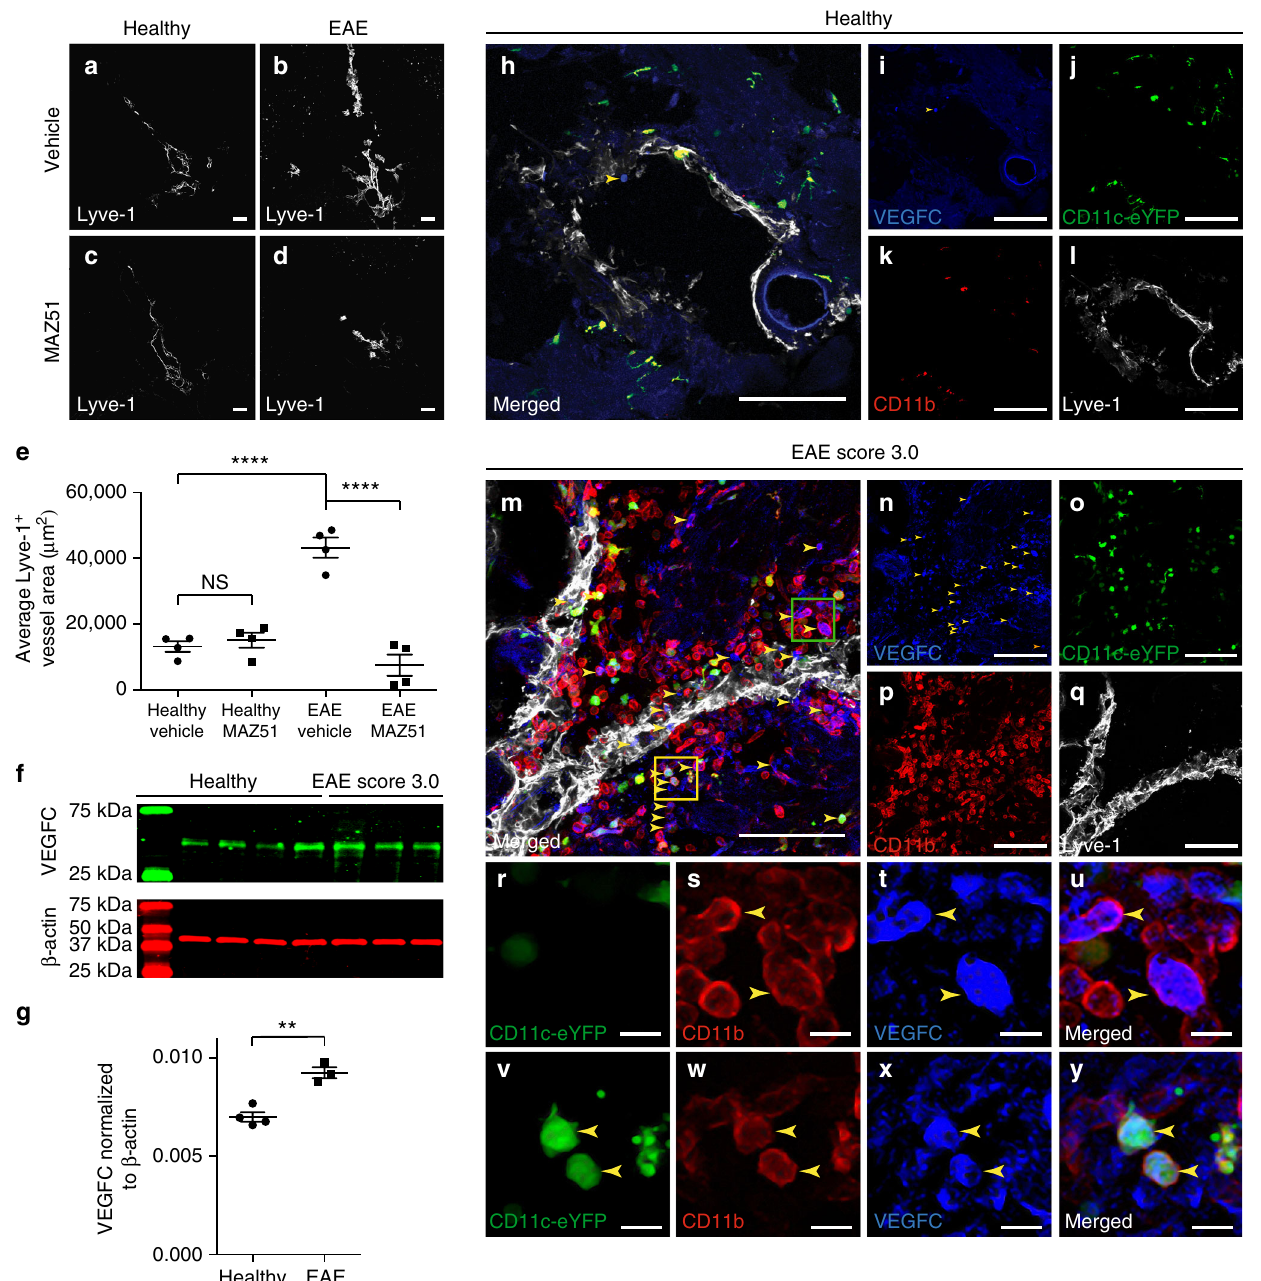
Fig. 4 EAE increases VEGFC to promote VEGFR3-dependent lymphangiogenesis. a – d Healthy ( a , c ) and EAE ( b , d ) wild-type mice were treated I.P. with either vehicle ( a , b ) or the VEGFR3 tyrosine kinase inhibitor MAZ51 ( c , d ) beginning on day 7 post-immunization and harvested at Day 18 post- immunization. The whole heads were decalci fi ed, and coronal sections were immunolabeled for Lyve-1 to visualize lymphatic vessels near the cribriform plate. Scale bars = 100 µ m. e Quantitation of the average Lyve-1 + vessel area near the cribriform plate between vehicle and MAZ51-treated mice in both healthy and EAE. For each animal, nine serial sections spanning 1920 μ m were analyzed and the section with the maximum Lyve-1 + vessel area was used for quantitation (mean ± SEM; n = 4 mice per group; **** p < 0.0001, one-way ANOVA with Tukeys post-hoc multiple comparisons test). f CNS lysates from healthy and EAE score 3.0 wild-type mice were probed for VEGFC and ß-actin as a loading control by western blot. g Quantitation of the relative VEGFC protein amount normalized to ß-actin as shown in d (mean ± SEM; n = 3 – 4 mice per group; ** p < 0.01, unpaired Student ’ s t -test). h – q Representative coronal section of a healthy ( h – l ) or EAE Score 3.0 ( m – q ) CD11c-eYFP transgenic reporter mice immunolabeled for CD11b, VEGFC, Lyve-1, and DAPI to visualize VEGFC-producing cells near cribriform plate lymphatics. Scale bars = 100 µ m. r – u Magni fi ed image of the green inset taken from m showing co-localization of CD11c-eYFP − CD11b + macrophages with VEGFC. Yellow arrowheads indicate CD11c-eYFP − CD11b + macrophages that express VEGFC. v – y Magni fi ed image of the yellow inset taken from m showing CD11c-eYFP + CD11b + dendritic cells expressing VEGFC. Yellow arrowheads indicate CD11c-eYFP + CD11b + dendritic cells that express VEGFC. Scale bars = 10 µ